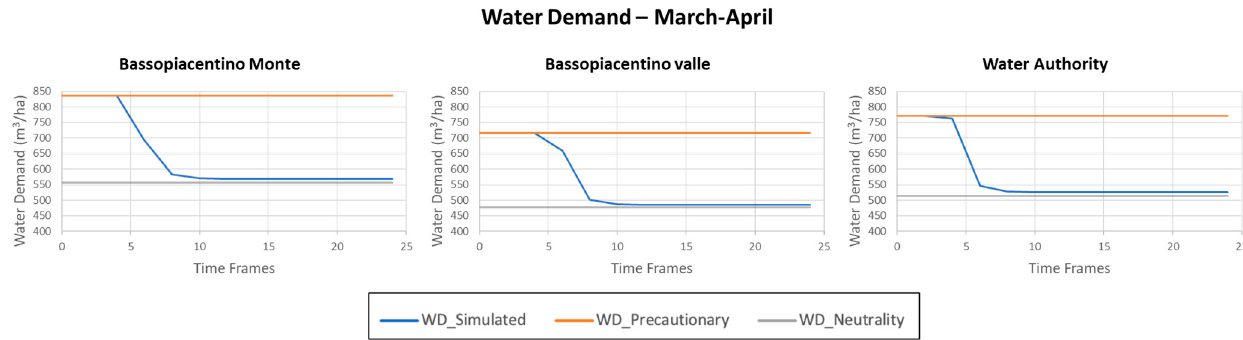
Figure 7. Comparison between actors of the evolving of WD in March–April.